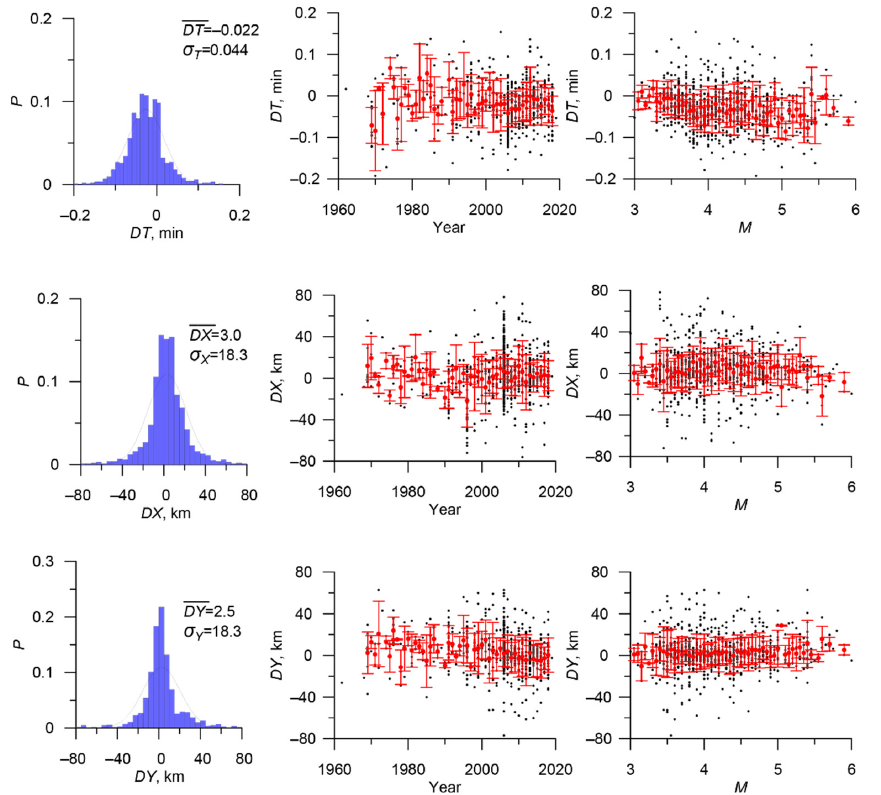
Figure 10. Distributions of DT , DX , and DY for the nearest events from the CORE/RUS_ISC catalogs, and the dependence of the standard deviations σ T , σ X , and σ Y and the mean values DT , DX , and DY on the time and magnitude of the events. The red dots and bars are the population mean values and standard deviations, respectively.